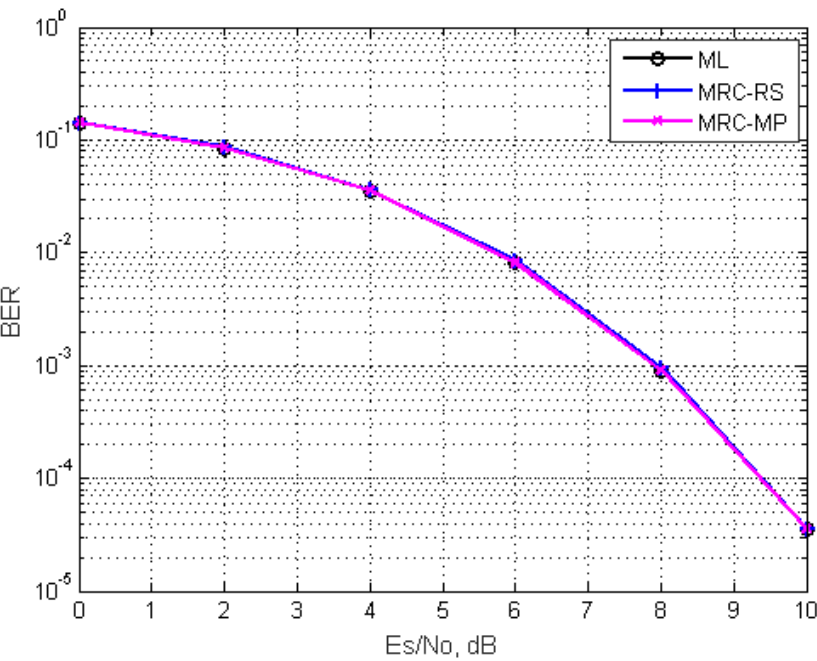
Figure 2. BER performance comparison of the proposed detectors and ML detector for GSM system in the presence of Rayleigh fading channel and perfect channel state information at the receiver with N t = 32, N r = 16, M = 8 and N p = 2.